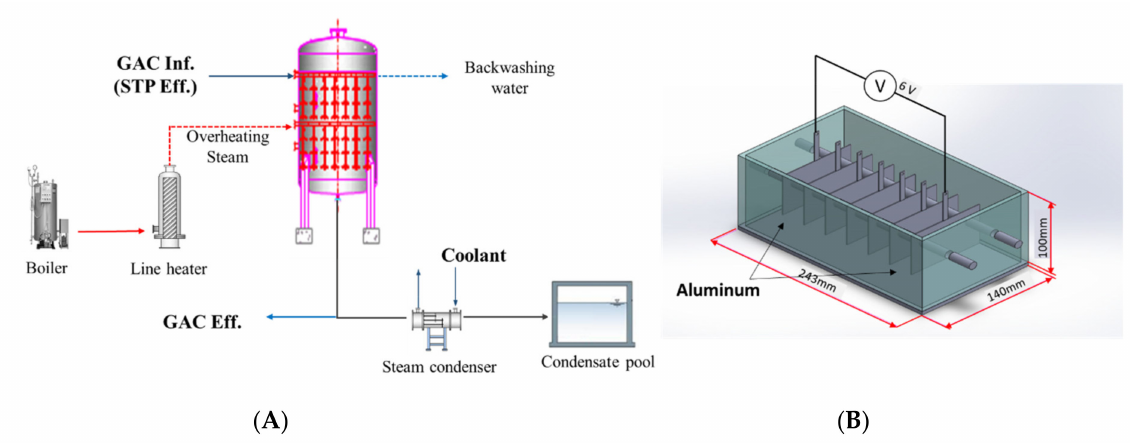
Figure 2. Experimental setup: ( A ) pilot-scale granule-activated carbon (GAC) unit; ( B ) lab-scale device for